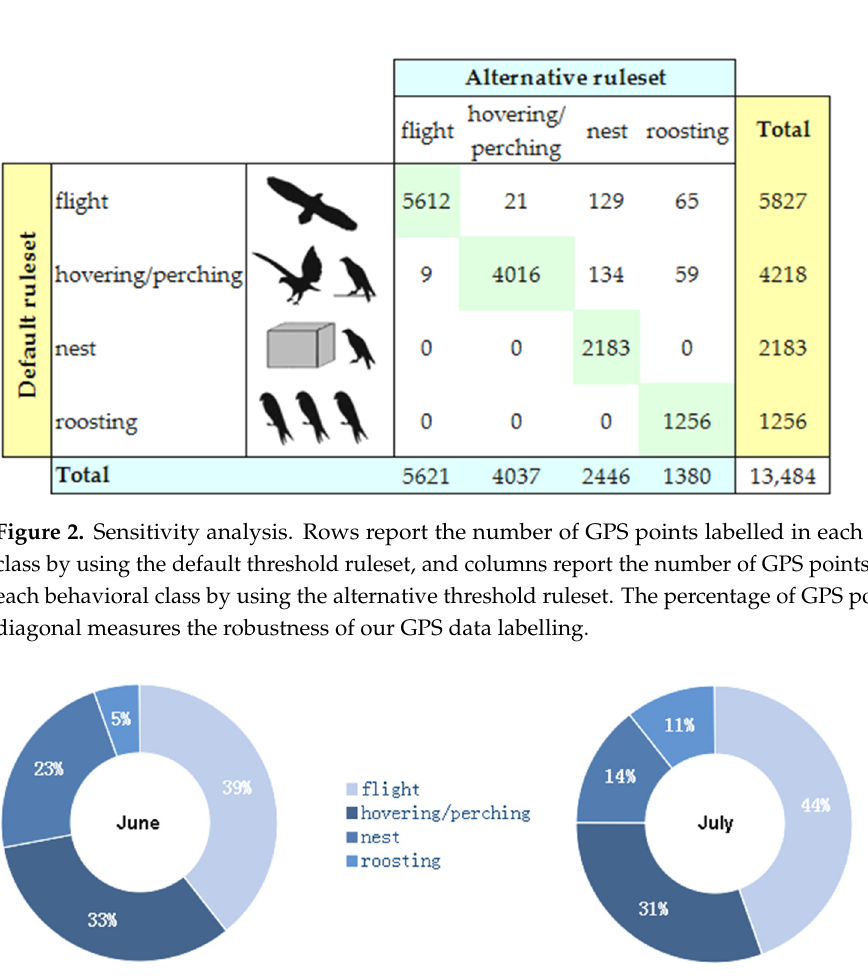
June vs. July activity budgets were significantly different (unconstrained Sample 1 vs.